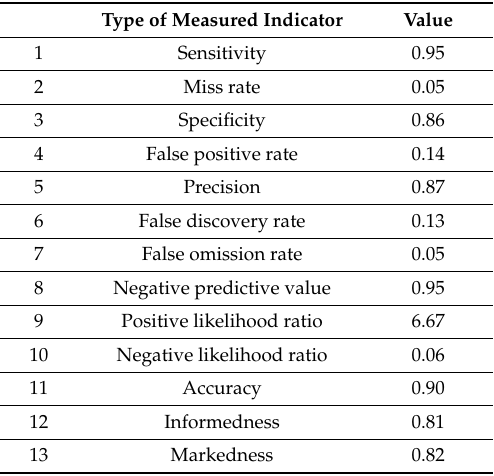
Table 4. Indicators of e ff ectiveness of the 10-3-2 artificial neuron network